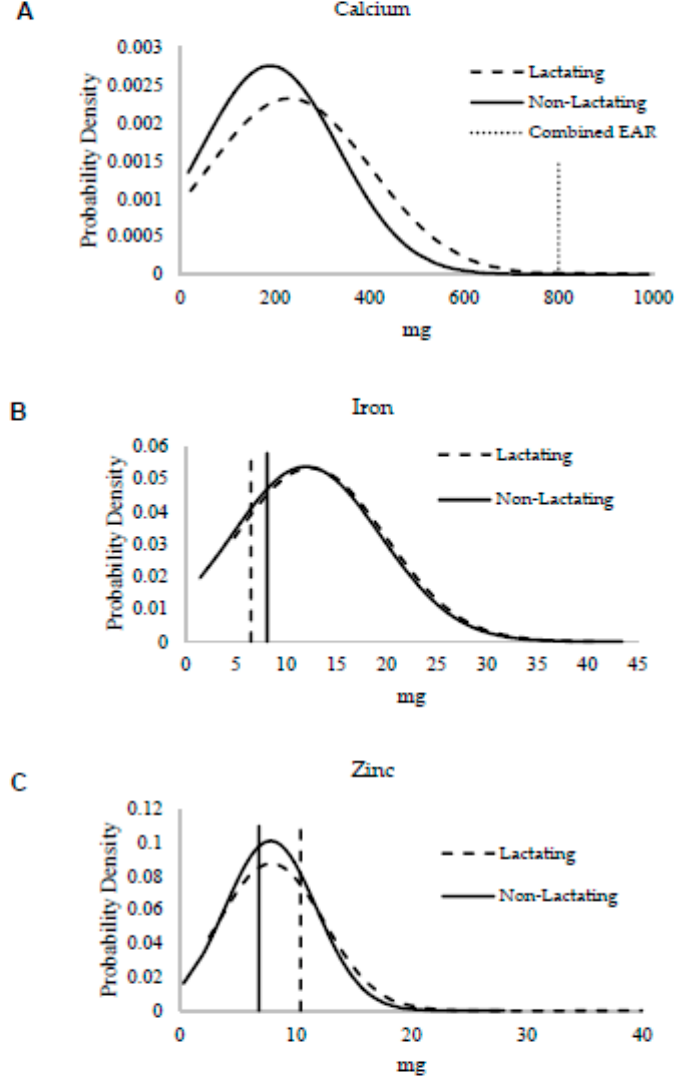
Figure 2. Overlaid mineral intake distributions from lactating (dashed curved line) and non-lactating (solid curved line) women assessed by 24-h dietary recall for minerals with estimated average requirements (EARs). Vertical lines represent EARs for minerals for lactating women (dashed line) and non-lactating women (solid line), the dotted vertical line represents EARs that do not differ with lactation in the case of calcium. Two-sample t -tests were used to compare mean intake differences for each mineral: ( A ) calcium ( p = 0.004), ( B ) iron ( p = 0.54), and ( C ) zinc ( p = 0.89).